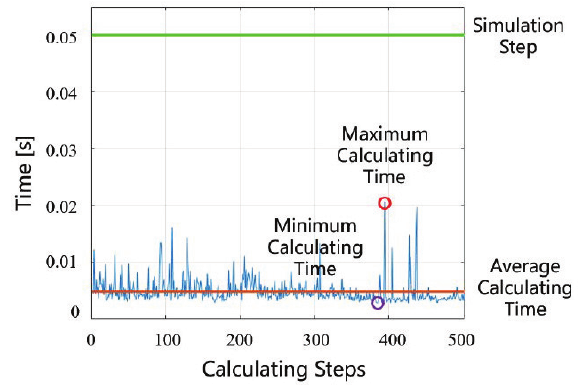
Figure 9. Calculating